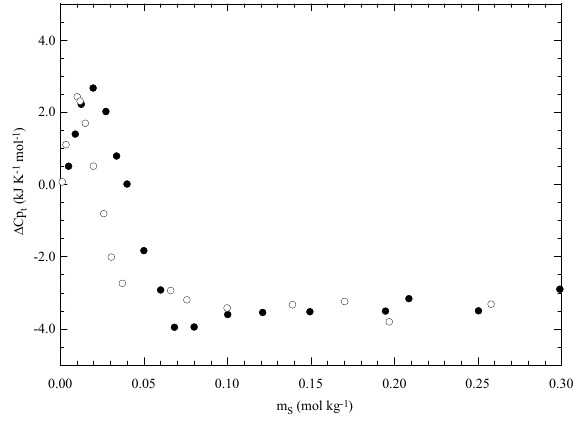
Figure 10. Heat capacity of transfer of L64 from water to the aqueous sodium